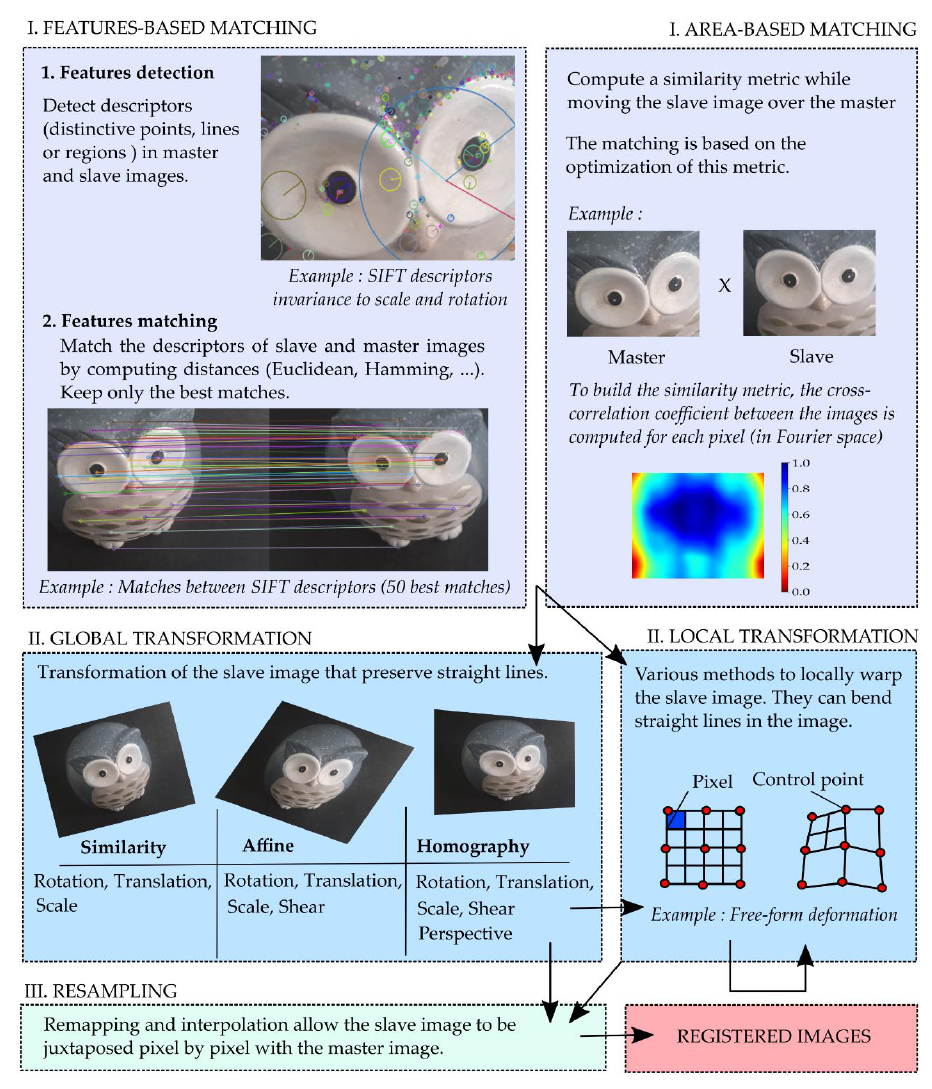
Figure 5. Overview of image-based registration pipeline.